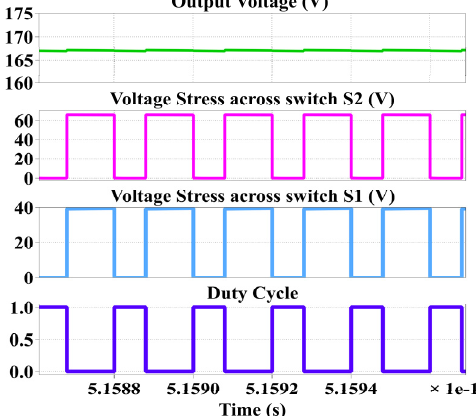
Figure 11. Output voltage and voltage stress across switch S 1 and S 2 at D = 0.4.